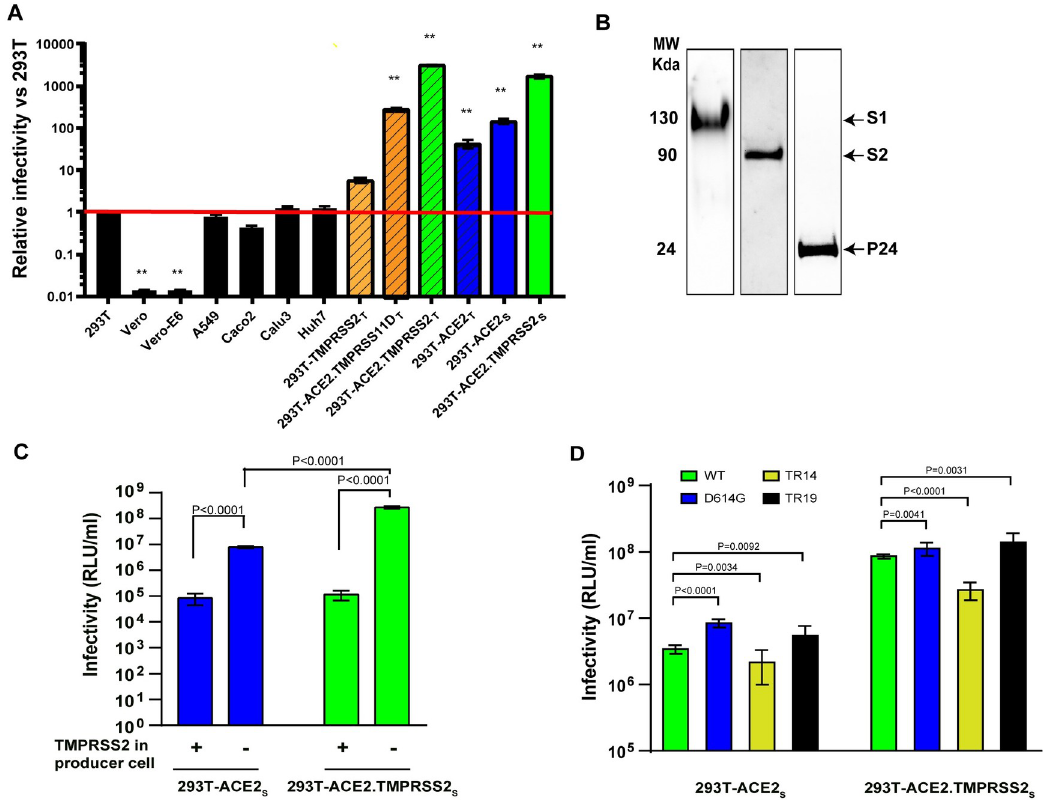
Fig 1. SARS-CoV-2 lentiviral pseudovirus infectivity under various conditions. (A) Relative infectivity of SARS-CoV-2 pseudoviruses in various target cells. The Y-axis shows relative infectivity compared to background in 293T cells. Subscript ‘t’ or ‘s’ refers to transient or stable expression, respectively. Red line indicates background level (1 x 10 4 relative units of luciferase activity/ milliliter or RLU/ml). (B) Western blots probed for spike S1/S2 subunits and HIV p24 incorporated into pseudoviruses. Lanes represent different blots (C) Infectivity on 293T-ACE2 s and 293T-ACE2.TMPRSS2 s of pseudoviruses primed with or without TMPRSS2 during pseudovirus production. (D) Infectivity on 293T-ACE2 s and 293T-ACE2.TMPRSS2 s of pseudoviruses bearing full-length, wildtype S glycoprotein (WT), an S glycoprotein with the D614G substitution, or S glycoproteins with C-terminal truncations of 14 (TR14) and 19 (TR19) amino acids. Data are shown as means and standard deviations from 3–4 independent experiments (panel A, C and D). The tests for two-group comparison were analyzed using GraphPad Prism software. P values of 0.05 were considered statistically significant. �� : P < 0.0001, compared to the infectivity in 293T.